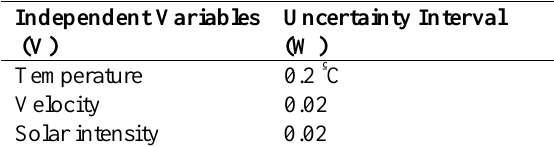
Error in calculating the value of collector